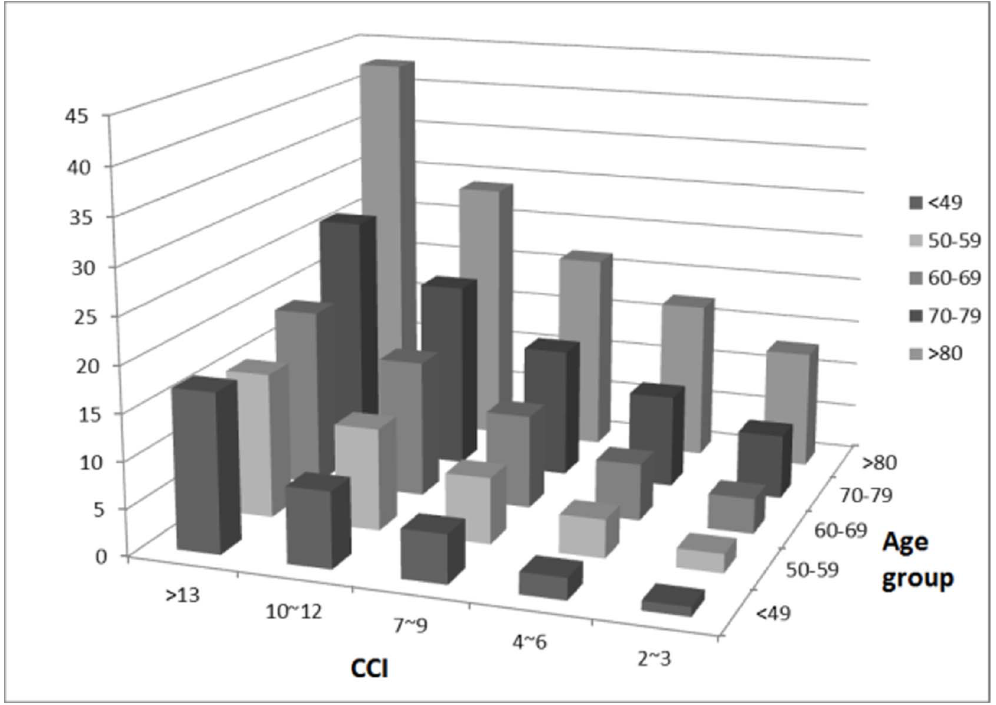
Figure 3. Increase of mortality with old age and high CCI in incident dialysis cohort. All the bars represent hazard ratio by age group and CCI.